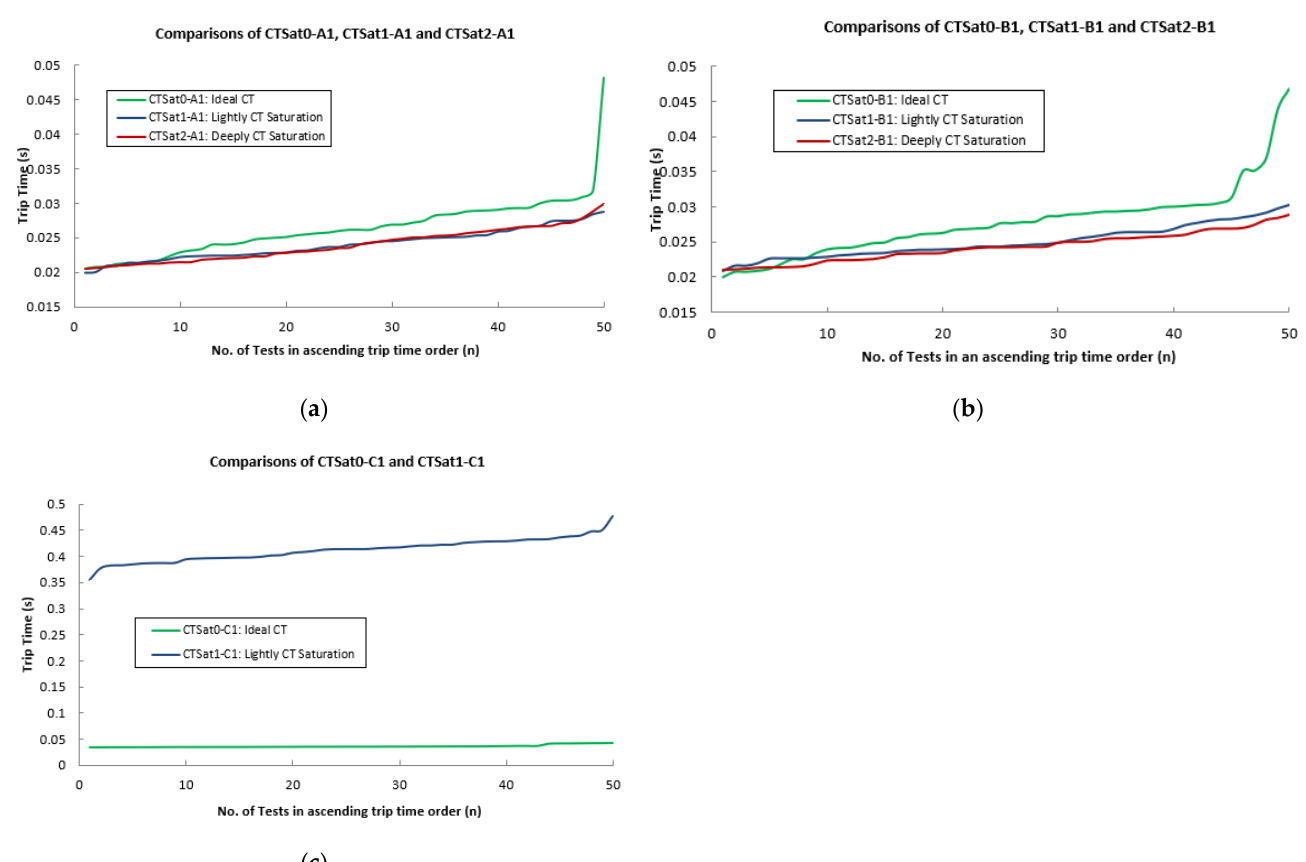
Figure 22. Comparisons: ( a ) CTSat0-A1, CTSat1-A1 and CTSat2-A1 (situations with different levels of CT, no faulty component, 3Ph-G fault at 50% of the feeder); ( b ) CTSat0-B1, CTSat1-B1 and CTSat2-B1 (situations with different levels of CT, 1 faulty fibre, 3Ph-G fault at 50% of the feeder); and ( c ) CTSat0-C1 and CTSat1-C1 (situations with different levels of CT, 1 faulty AMU, 3Ph-G fault at 50% of the feeder).